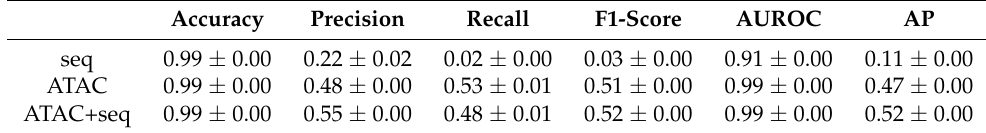
Table 5. MCF7 cell line training–evaluation